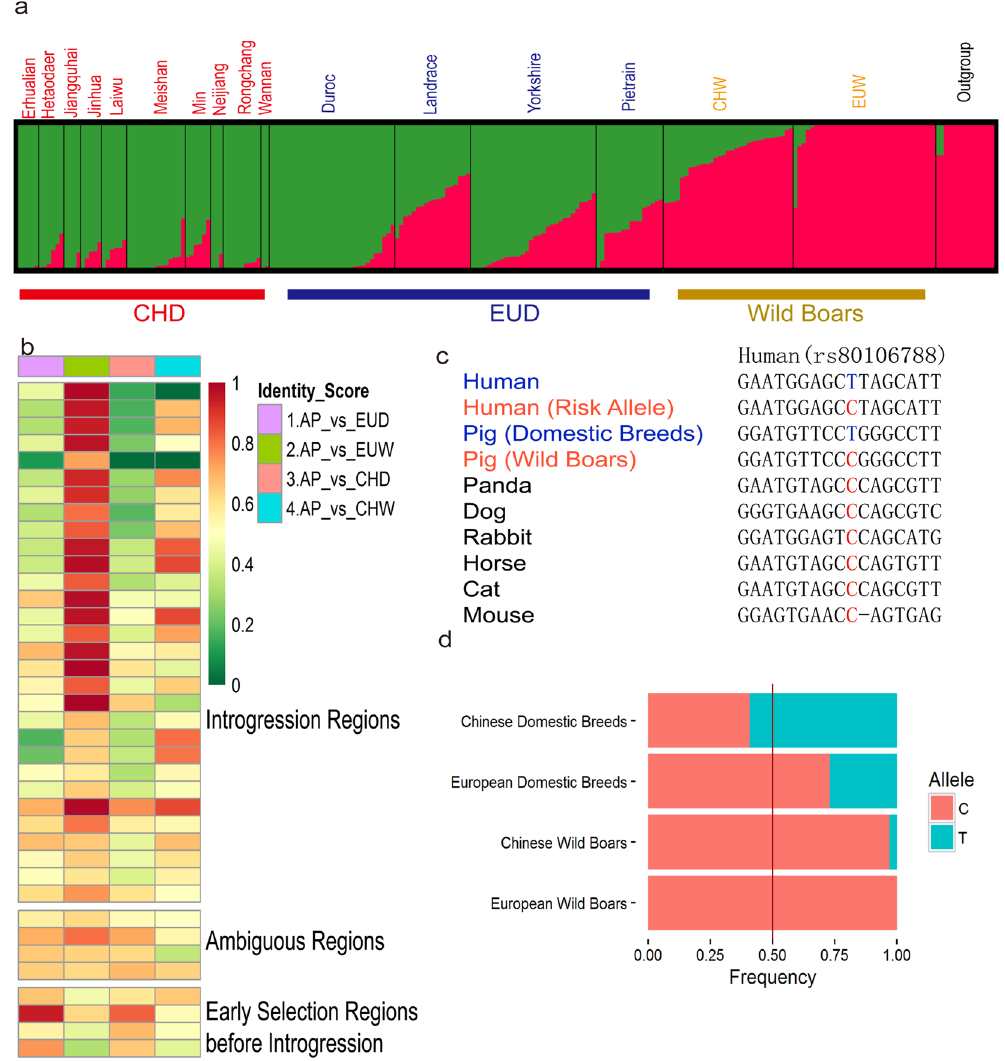
Figure 4. Genomic regions under unidirectional selection and the variant features in ITPR3 . ( a ) Genetic structure of pig breeds in unidirectional selection region. The length of each colored segment represents the proportion of the individual’s genome from K = 2 ancestral populations. The group names are at the top of the figure, and the breed names are at the bottom. ( b ) The heatmap for the identity score of unidirectional selected regions between the ancient pig (AP) and other four groups. SNP frequencies in individual lines were used to calculate identity scores in 20-kb windows. Heat-map colors (right) indicate identity scores. ( c ) The multi-species alignment of human rs80106788 variant in the ITPR3 gene. ( d ) The allele frequency of the pig rs332886460 in each